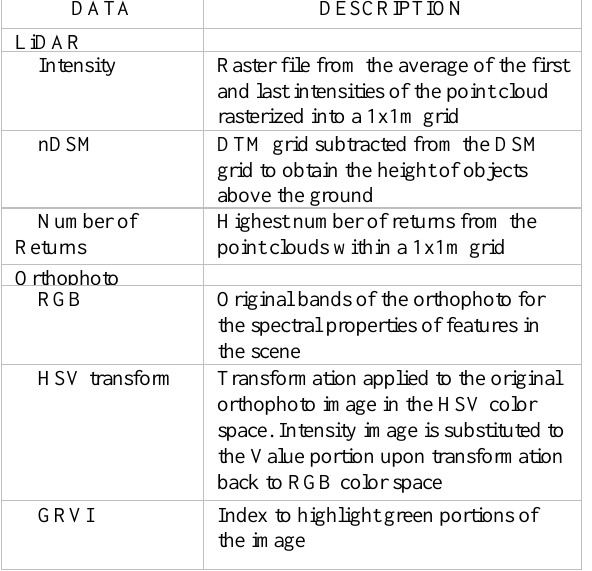
Figure 2. Subset of the study area showing segmentation for shadowed and non-shadowed